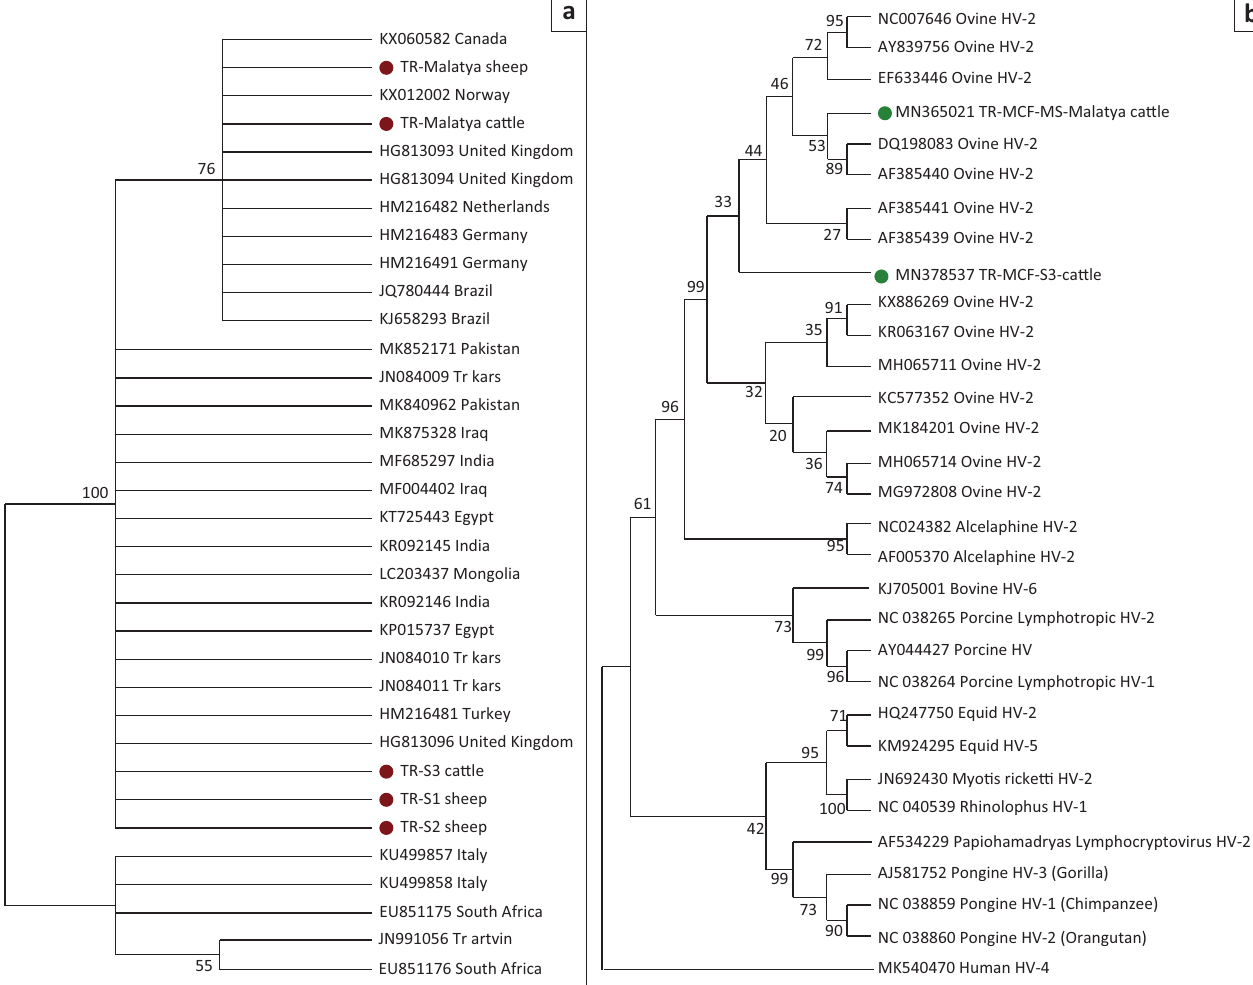
FIGURE 2: Phylogenetic analyses by using tegument (a) and gB (b) gene sequences of ovine herpesvirus 2 strains in this